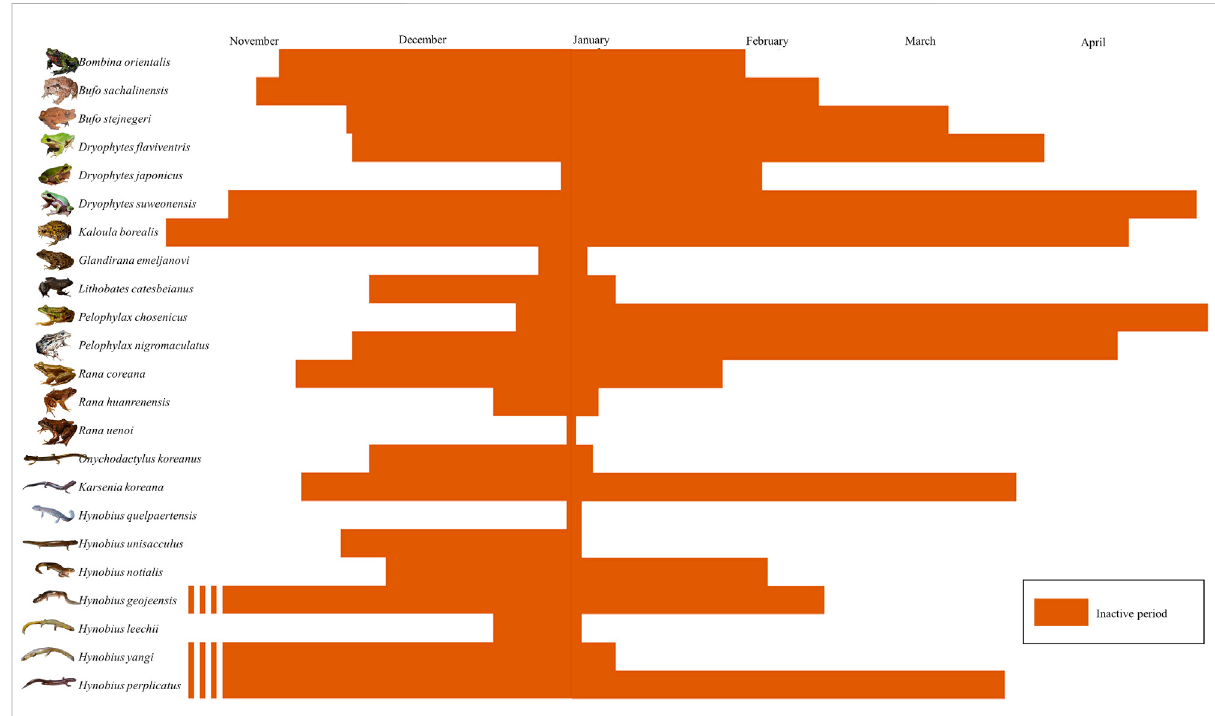
FIGURE 2 Inactive period for all Korean amphibians based on citizen science data. The onset of inactive period is missing for three Hynobius species because of the lack of data. The analysis is based on 8,763 citizen science observations collected between 02 March 1997 and 01 December 2020 downloaded from the platform